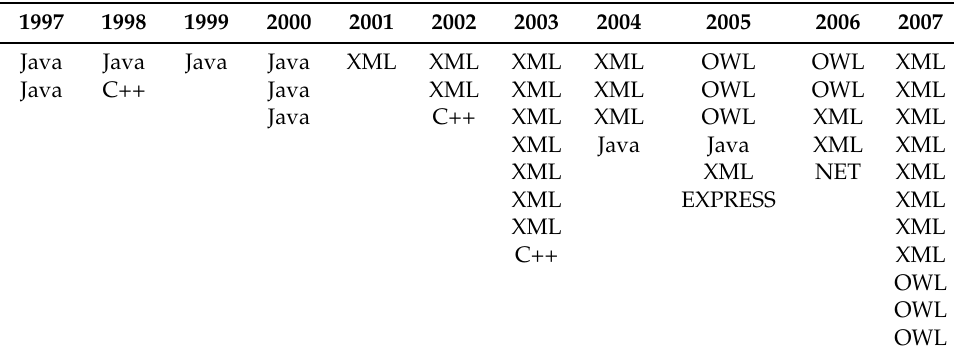
Table 8. Representation of IFC when implementing the IFC information model in software.